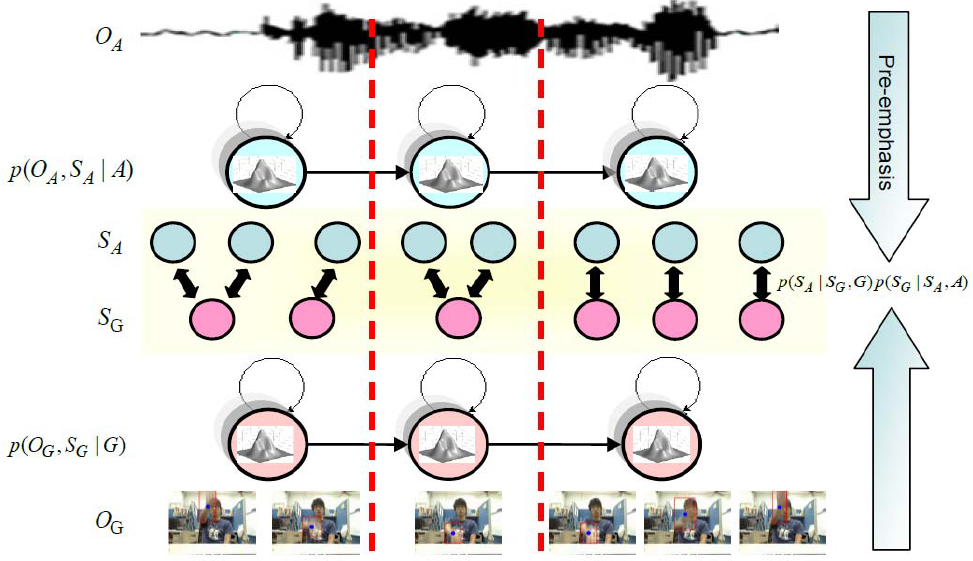
Figure 18. Multimodal model